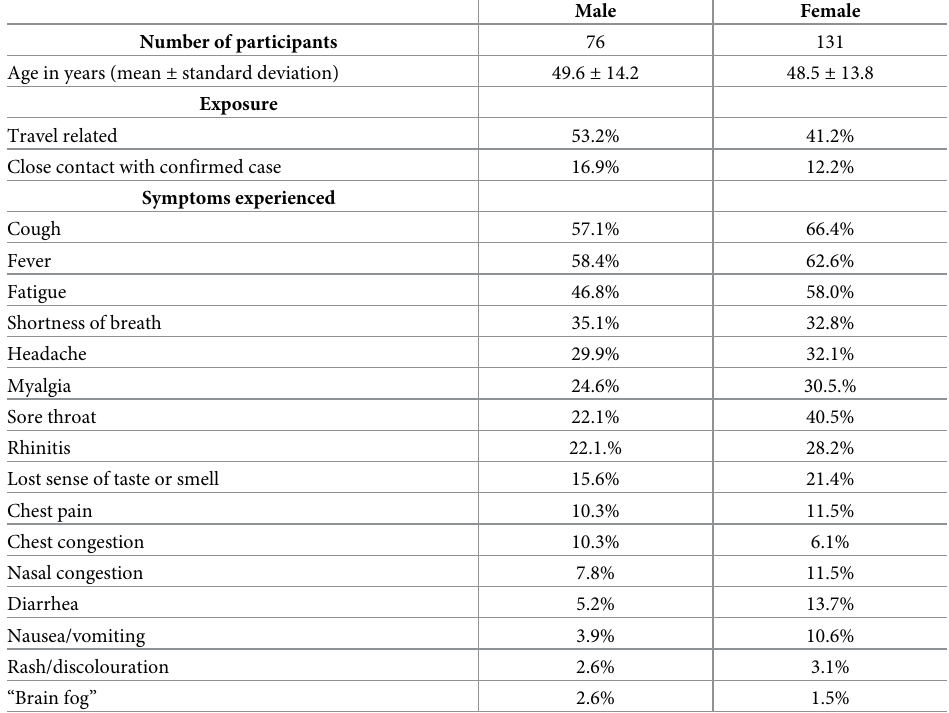
Table 2. Age, sex and symptoms of persons suspecting exposure to SARS-CoV-2 without PCR-based diagnosis of active infection or serological evidence of past